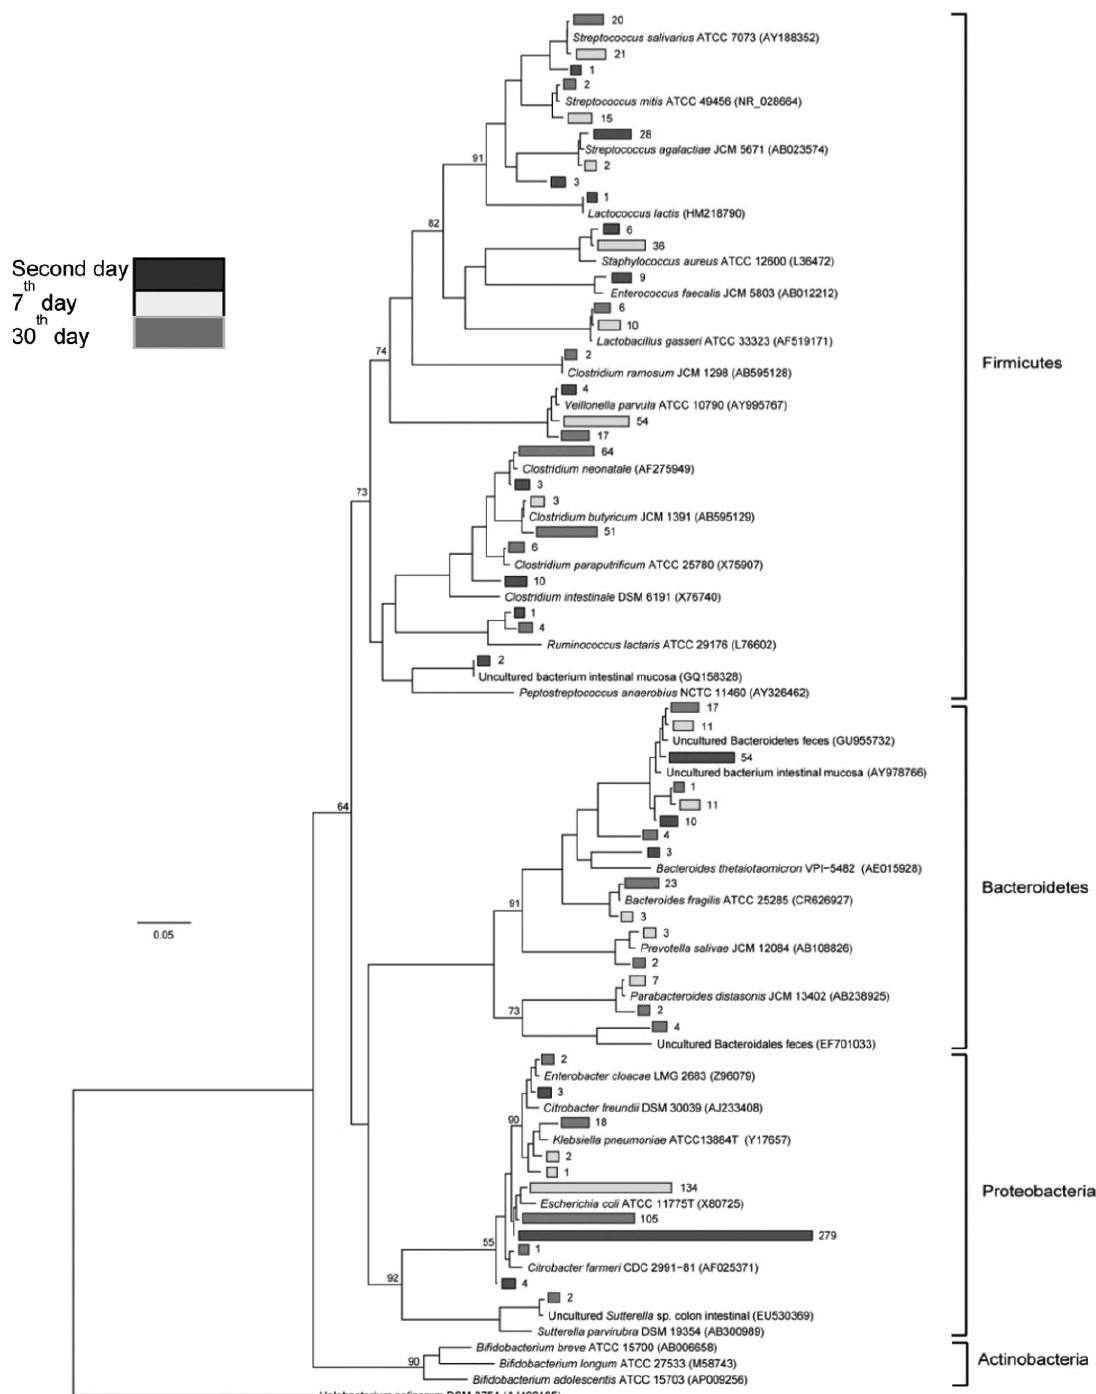
Figure 5 - Phylogenetic relationships among the OTUs detected in newborn fecal samples. Black branches represent the 2-day-old samples, white branches represent 7-day-old samples and gray branches represent 30-day-old samples. Reference sequences are indicated by their taxonomic names, and uncultured clones are followed by their GenBank